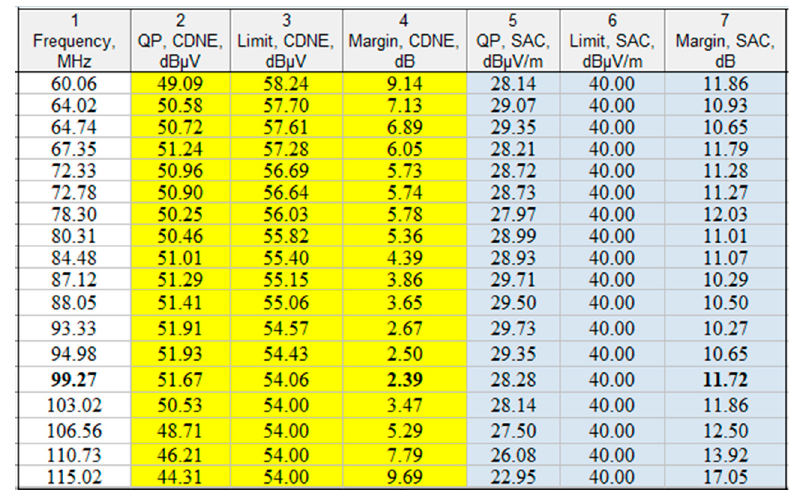
Figure 6. Selected SAC and CDNE measurement results for LED lamp A.